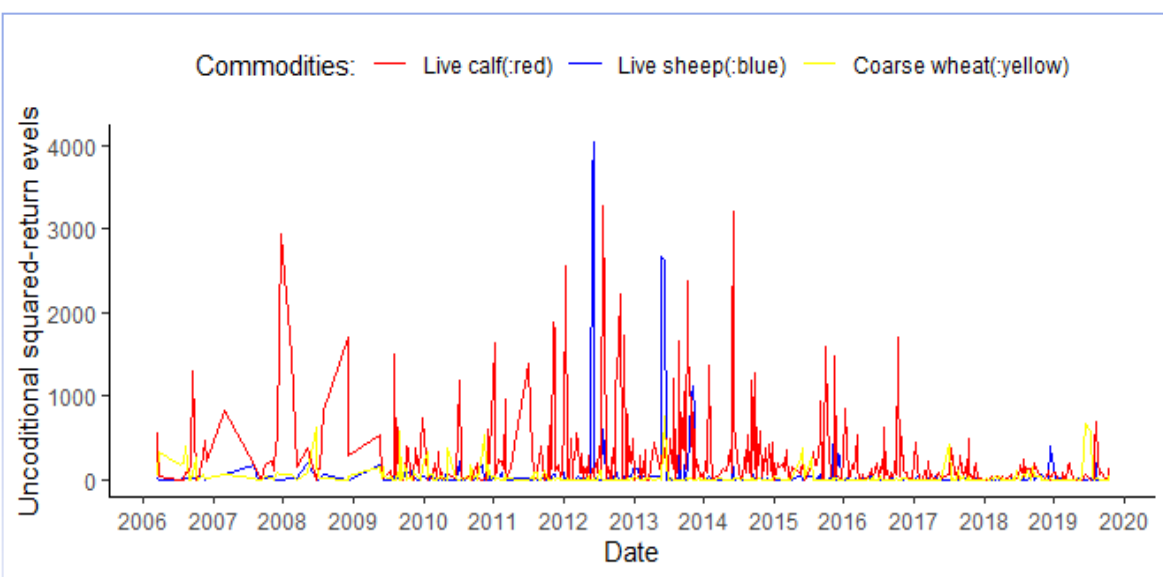
Figure 2. Time-varying return series of live calves, live sheep, and coarse wheat.